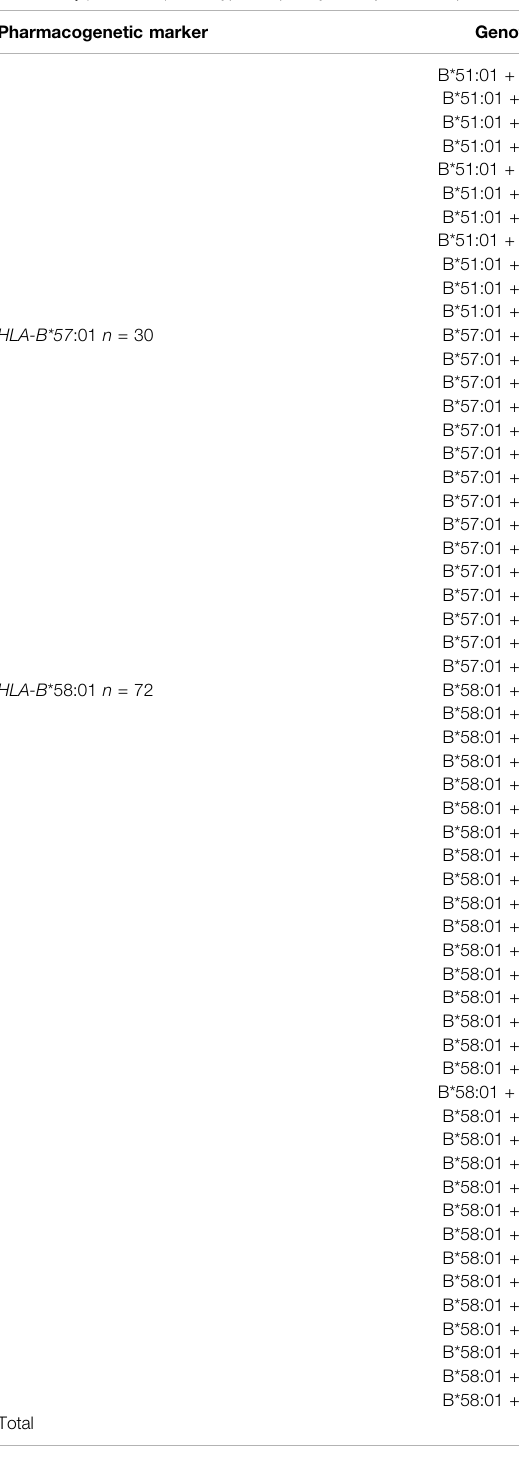
TABLE 4 | ( Continued ) Genotype frequency of major HLA-B pharmacogenetics markers in Qatari